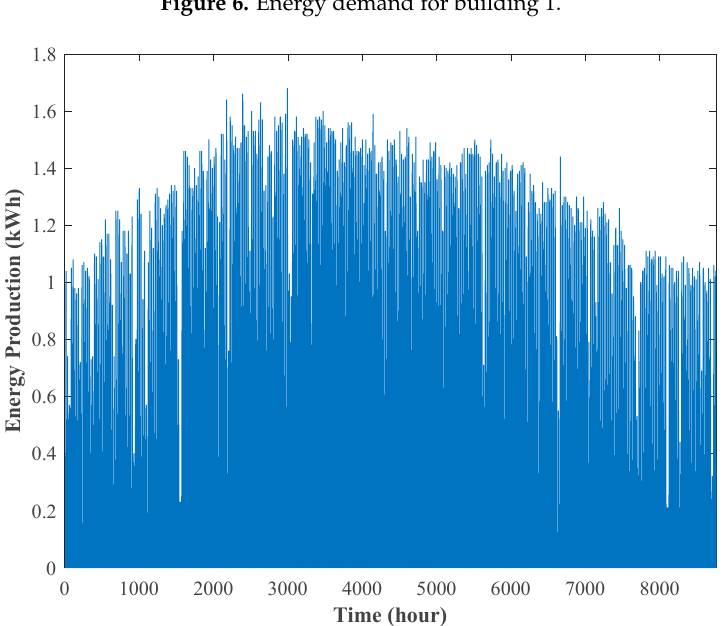
Table 6. Annual payment for different scenarios.